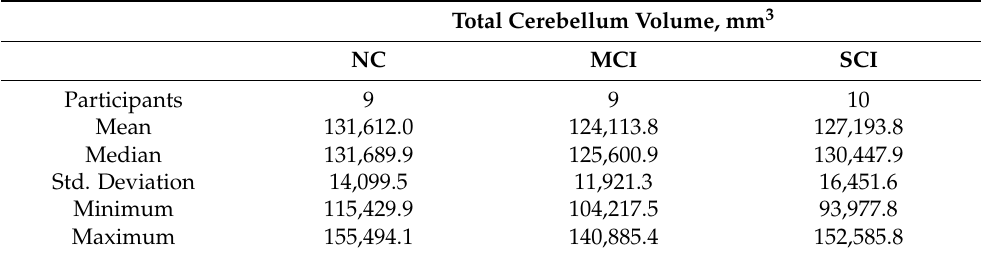
Table 6. Descriptive statistics for total cerebellar volume in participants with normal cognition (NC), mild cognitive impairment (MCI), and moderate/severe cognitive impairment (SCI).